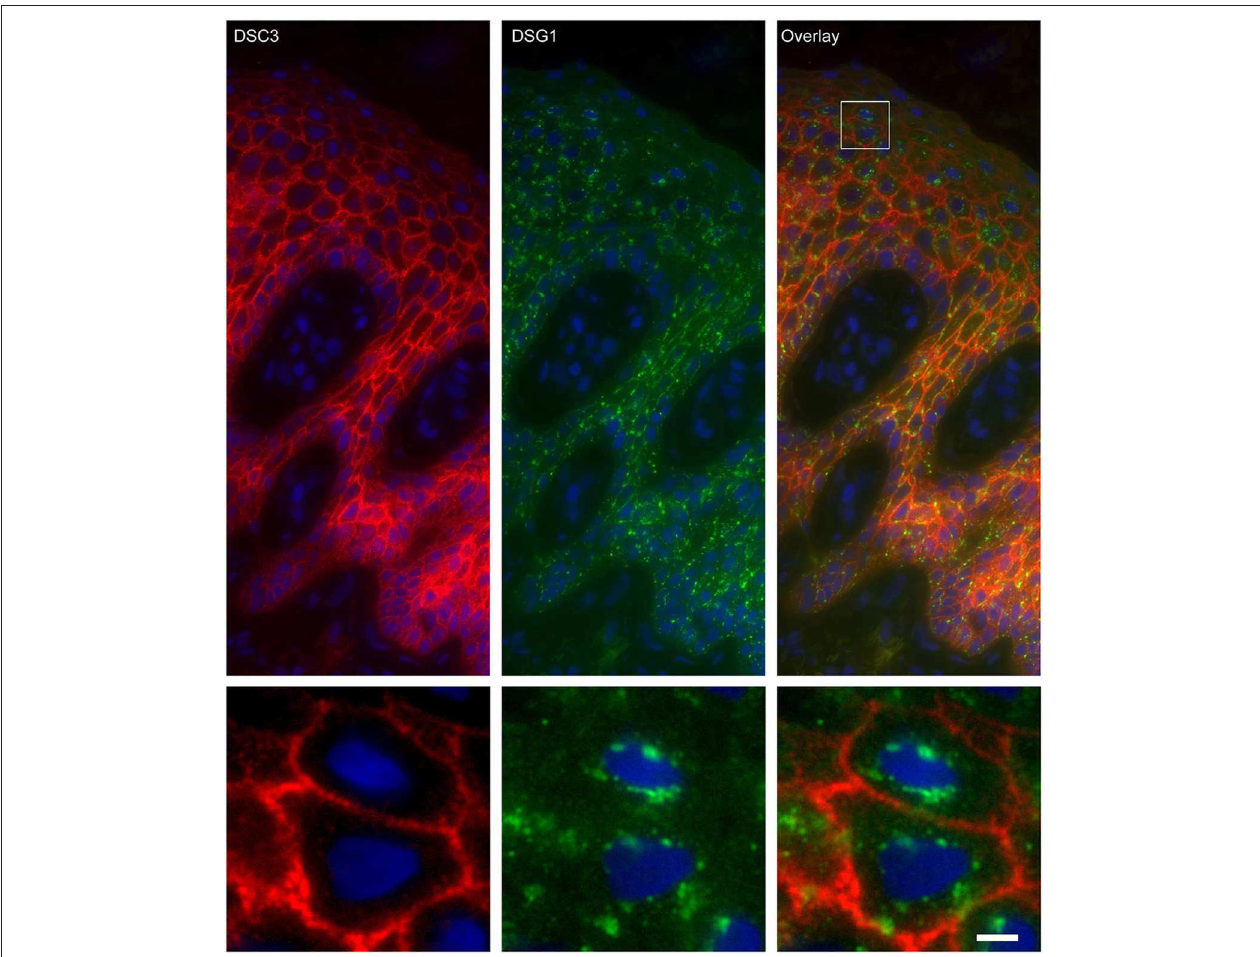
FIGURE 6 | Double staining of desmoglein 1 and desmocollin 3 shows no overlap in endosomes. The upper panel shows the overview, the lower panel shows the detail from the white box in the upper panel. White bar is 5 µ m.